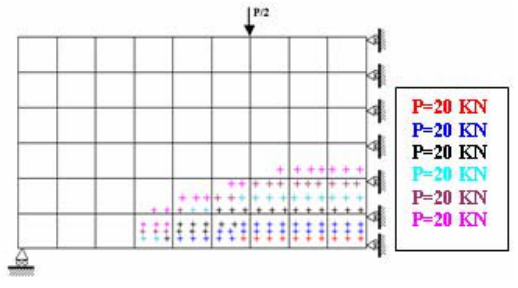
Fig. 13. Finite element crack pattern of the